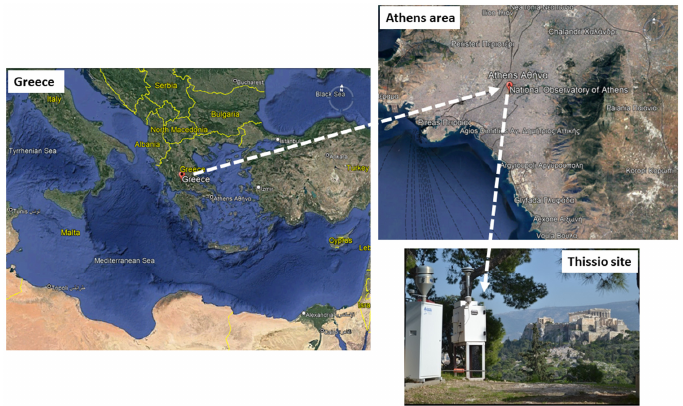
Figure 1. Satellite image of Greece, zooming into the city center of Athens, and focusing on the urban background site of Thissio at the top of Nymphs Hill in central Athens (37.97326° N, 23.71836° E, 105 m a.s.l).